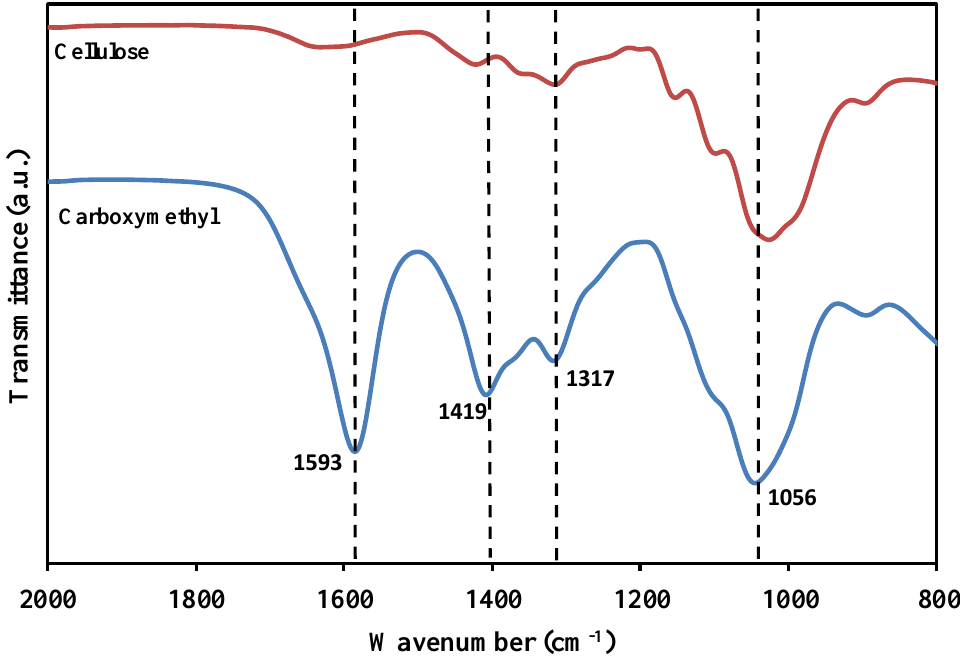
Figure 4. IR spectra of cellulose and CMC in the region between 2000 and 800 cm −1 .